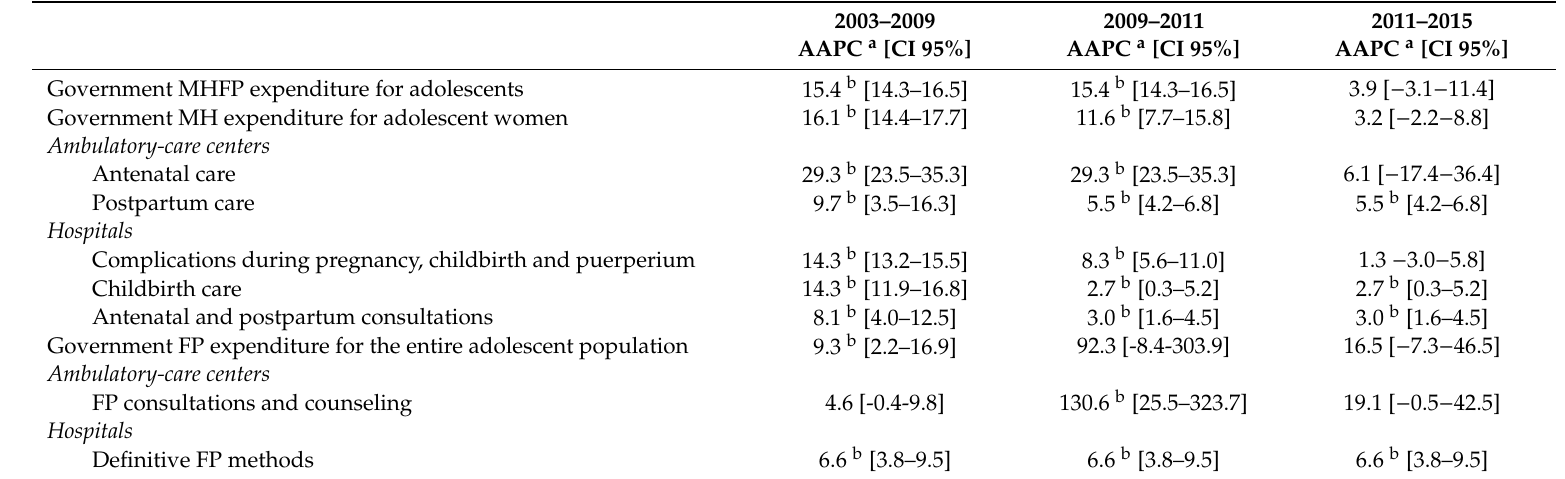
Table 1. Average annual percent change in government Maternal Health and Family Planning (MHFP) expenditure for the entire adolescent population aged 10–19 without Social Security coverage, Mexico,